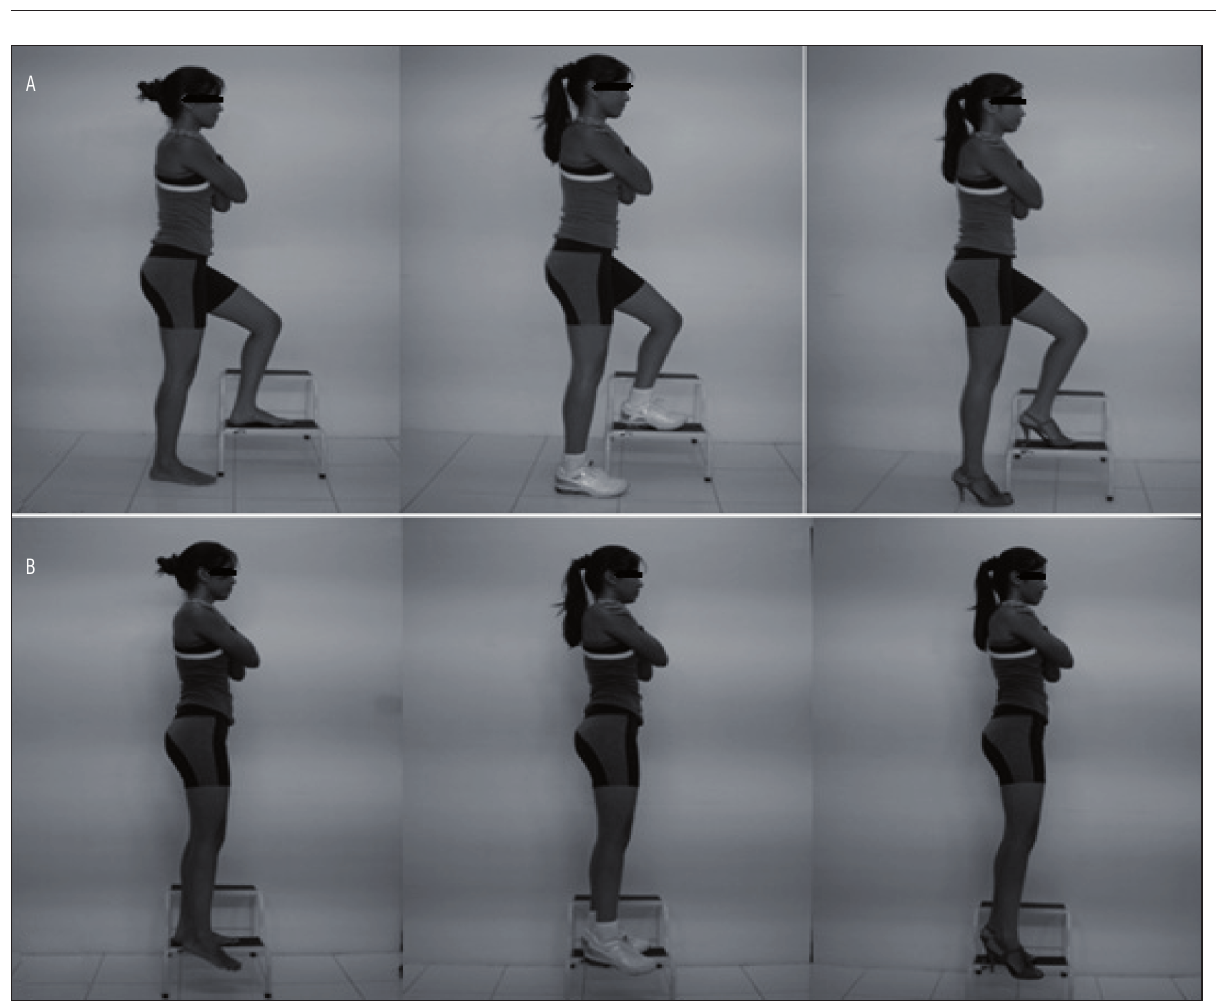
Figura 1 - Posição de execução das atividades de subir o degrau (A) e descer o degrau (B) com a voluntária descalça, com tênis e salto alto Fonte: Dados da